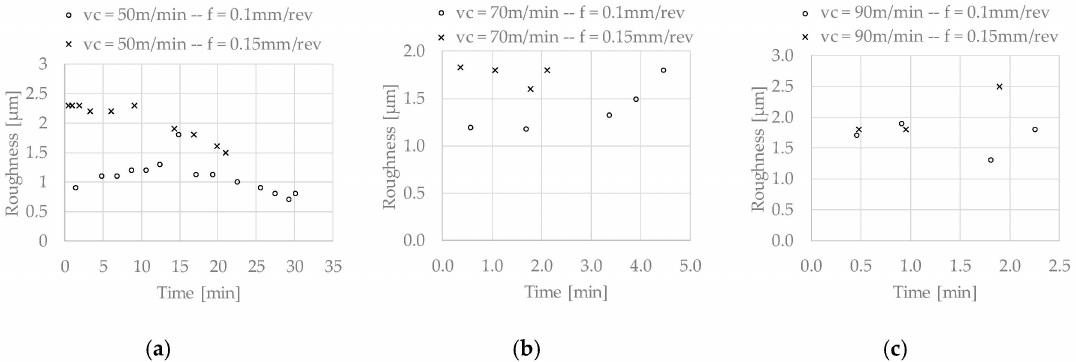
Figure 5. Roughness evolution at the machined surface for all of the cutting conditions tested: ( a ) V c = 50 m / min, ( b ) V c = 70 m / min, ( c ) V c = 90 m /